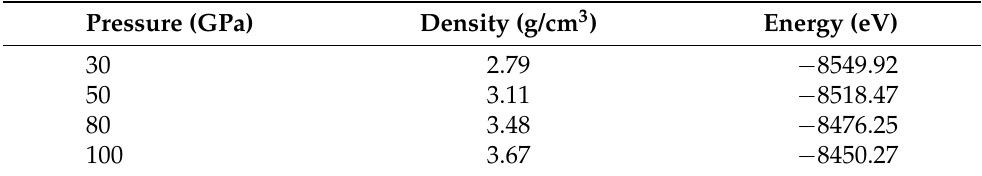
Table 1. Density of the crystal structure consisting of 8 Td-N 4 molecules. This structure was optimized by applying external pressure on the basis of a PWmat